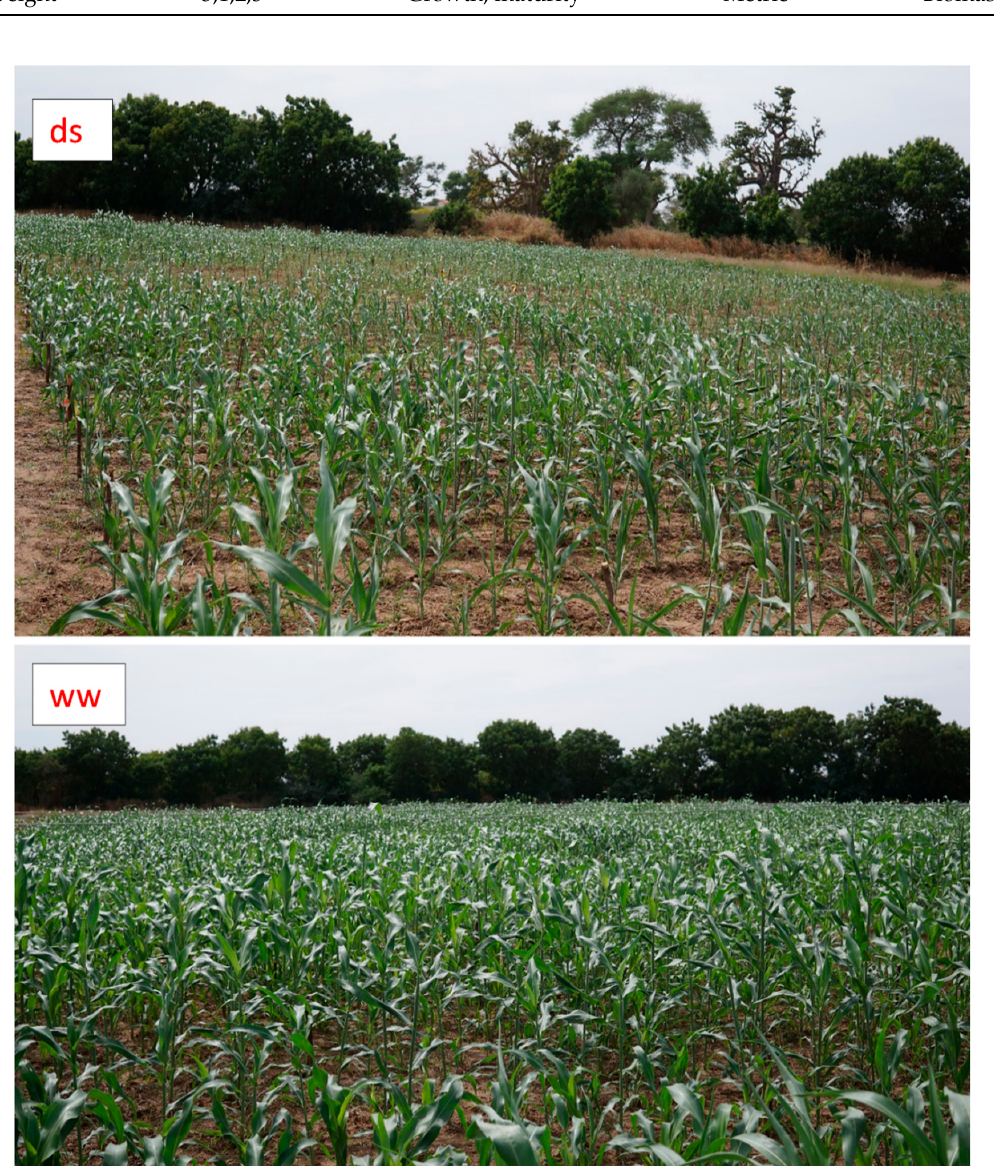
Figure 6. Picture depicting an overview of the stressed (ds) plots of the ten varieties at the 30th day after the onset of the drought stress compared to the well-watered (ww) ones during the 2019 field trial.